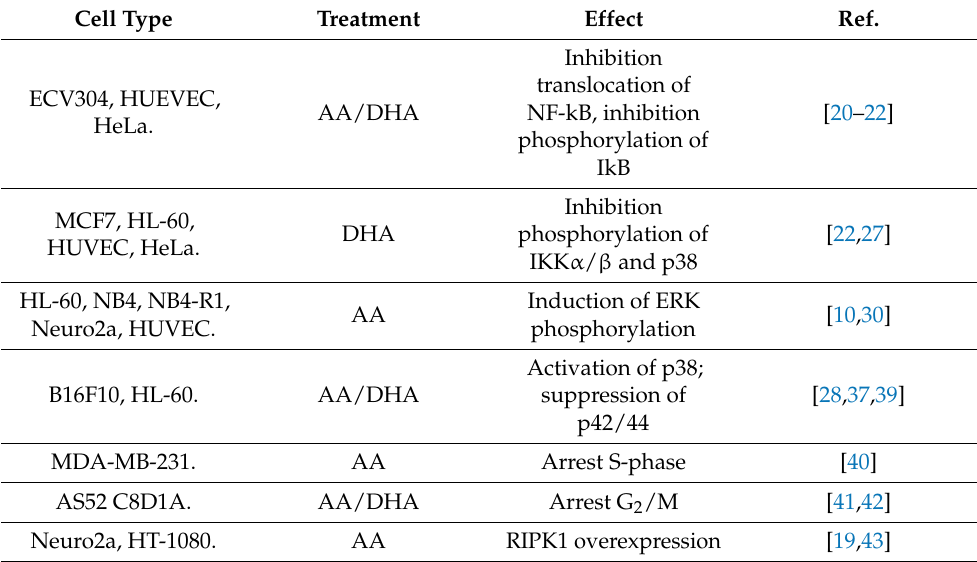
Table 1. Molecular pathways regulated by vitamin C in different cell